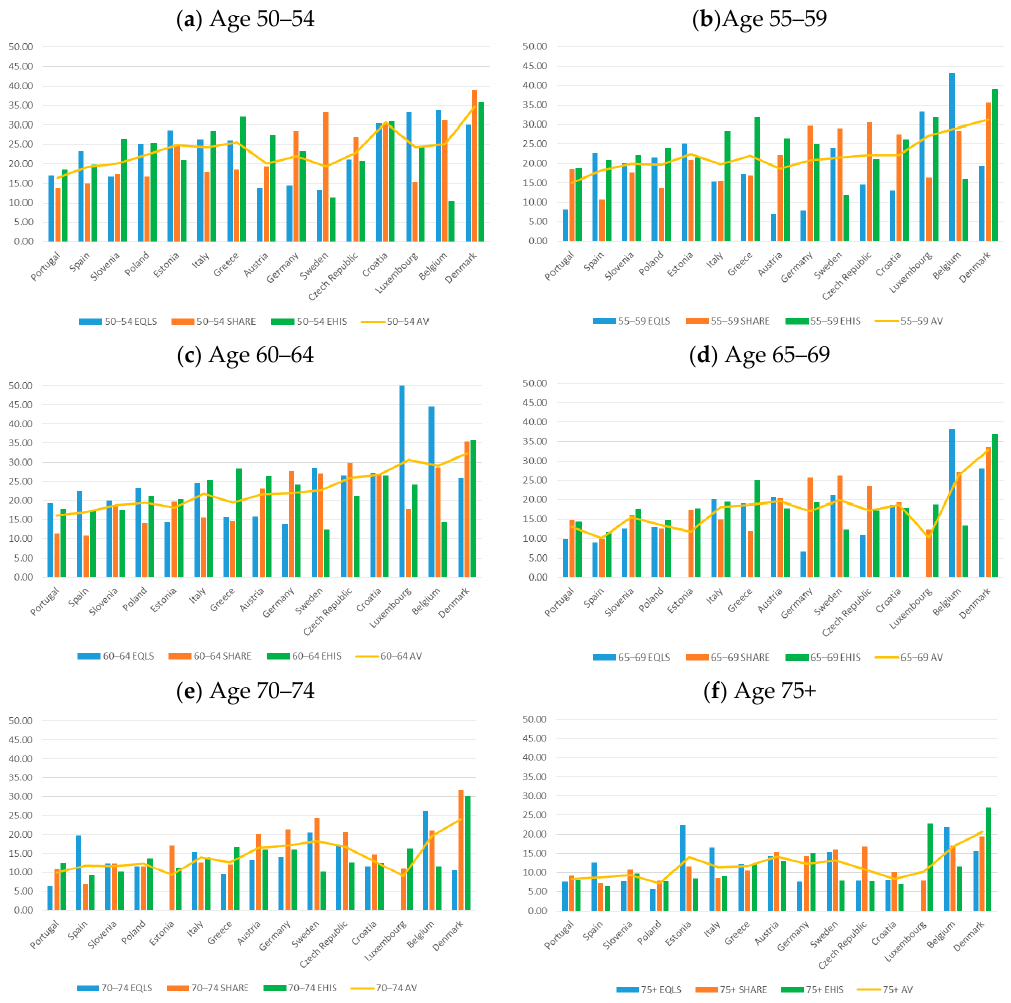
Figure 6. Informal Caregivers over 50, by age group (weighted) (percent) ( a ) Age 50–54 ( b ) Age 55–59 ( c ) Age 60–64 ( d ) Age 65–69 ( e ) Age 70–74 ( f ) Age 75+ (Small sample size regarding Slovenia, Estonia and Luxemburg; therefore results should be interpreted with caution). EQLS = European Quality of Life Survey; SHARE = Survey of Health, Ageing and Retirement in Europe; EHIS = European Health Interview Survey; AV=Average.